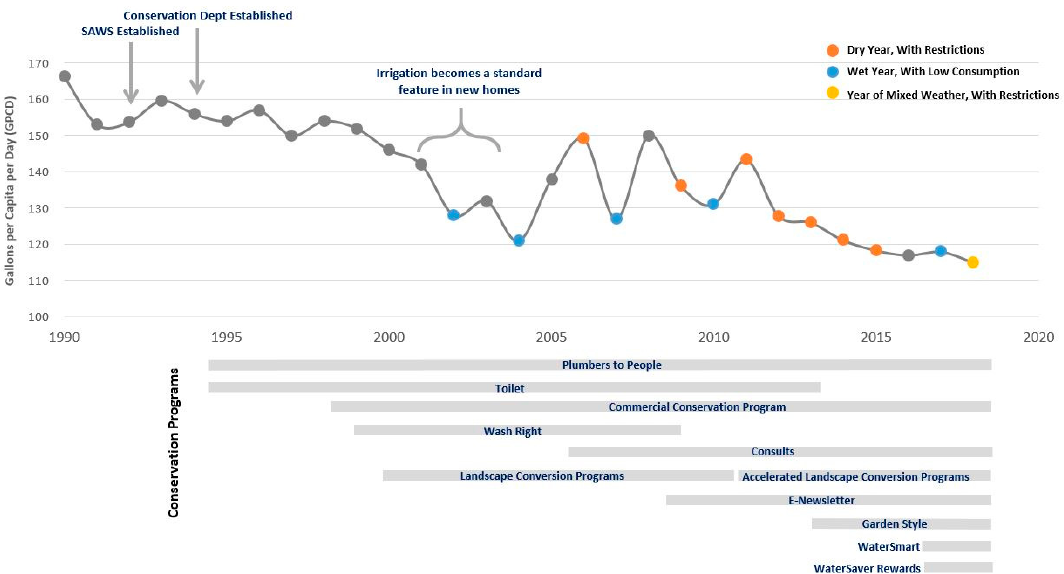
Figure 4. The San Antonio Water System has implemented more than 30 different conservation strategies over the past 25 years, enabling the utility to reduce total per-capita water use by 26% [37]. This chart illustrates inter-annual progress made in reducing total per-capita water use and the years during which some of their most important strategies were implemented (illustration provided by San Antonio Water System).